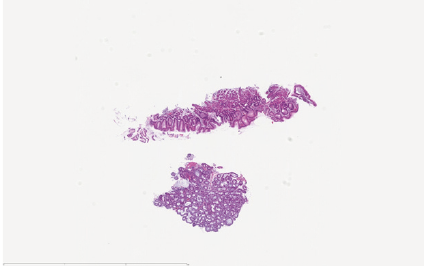
Figure 3: Low-magnification appearanceof the heterotopicsalivary gland tissue that was received as detached fragments.